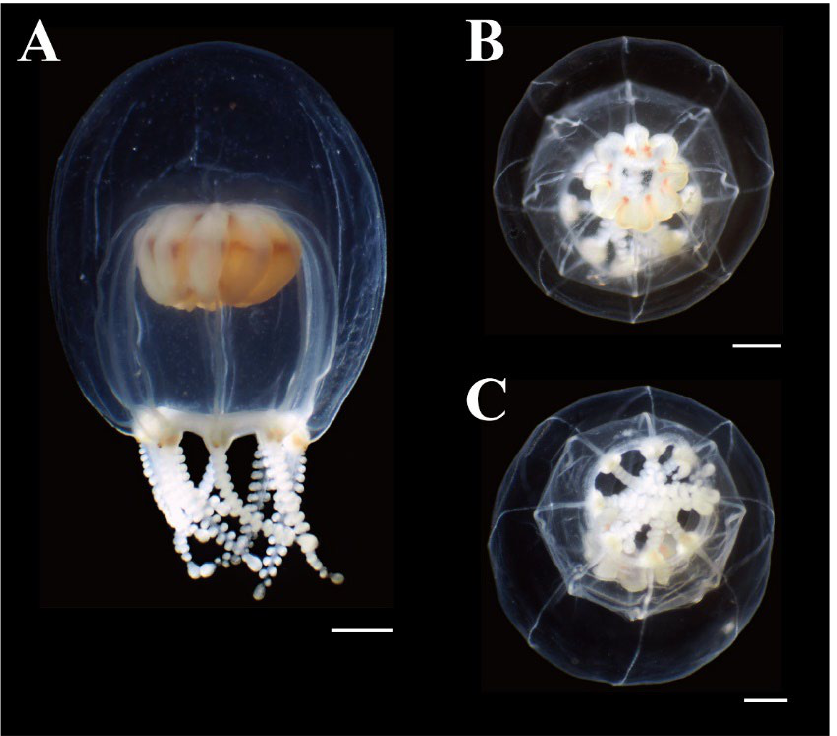
Figure 5. Preserved mature medusae of Octorhopalona saltatrix sp. nov. (NSMT-Co1802): ( A ) lateral, ( B ) apical, and ( C ) oral views. Scale bars: 1 mm.